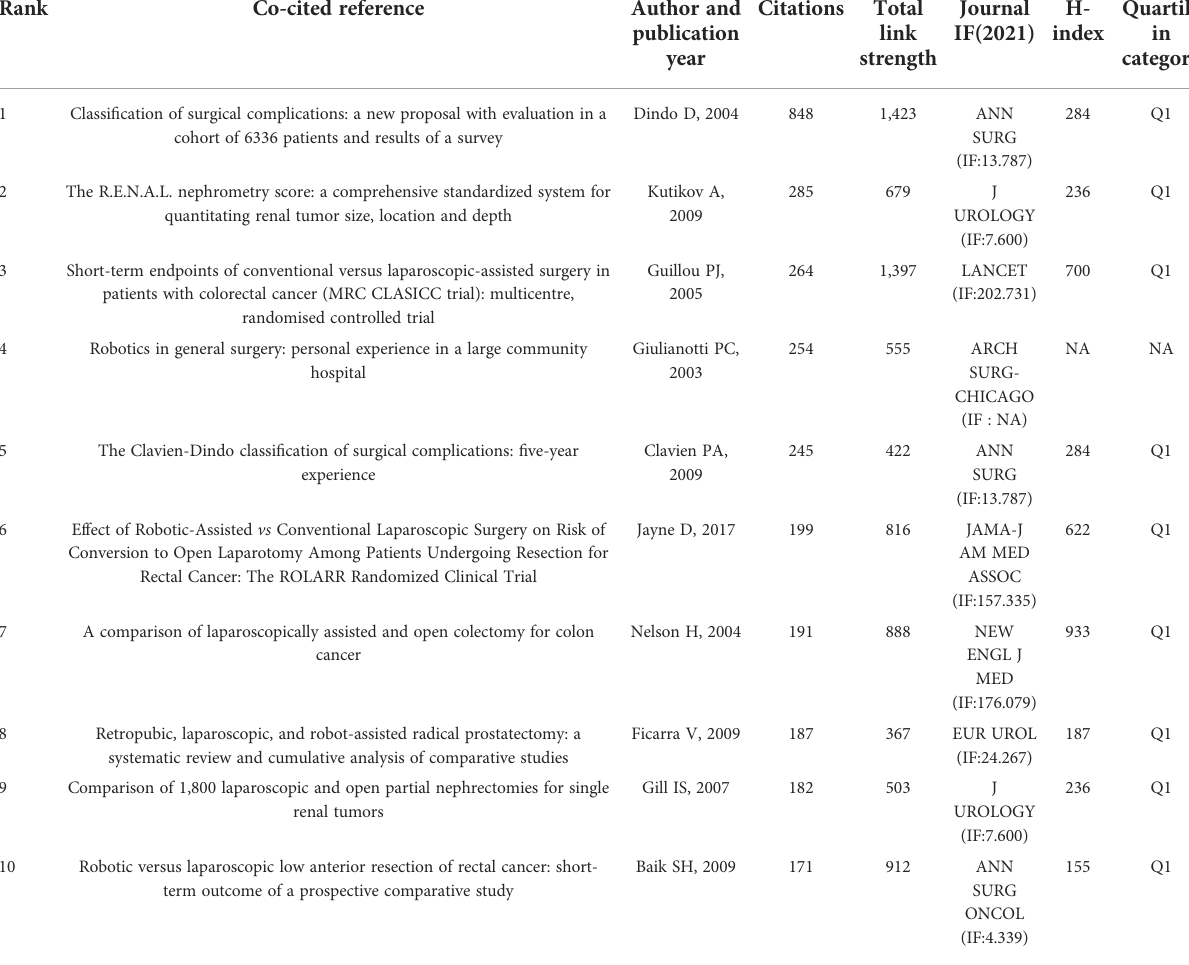
TABLE 7 The top 10 co-cited references in terms of citation frequency related to robotic surgery in